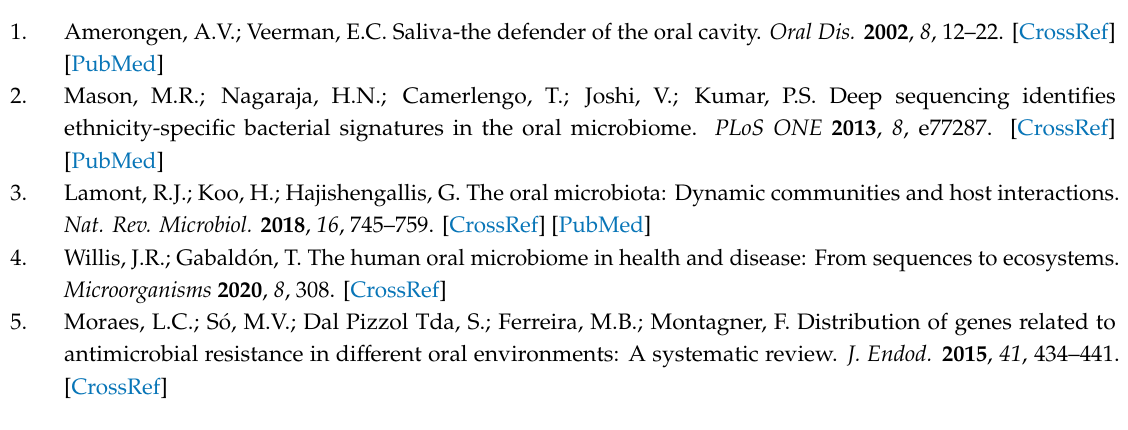
Table S1: The list of vegans, ovo-lacto vegetarians and omnivores included in study, each identified with an anonymous code, age, sex and geographical